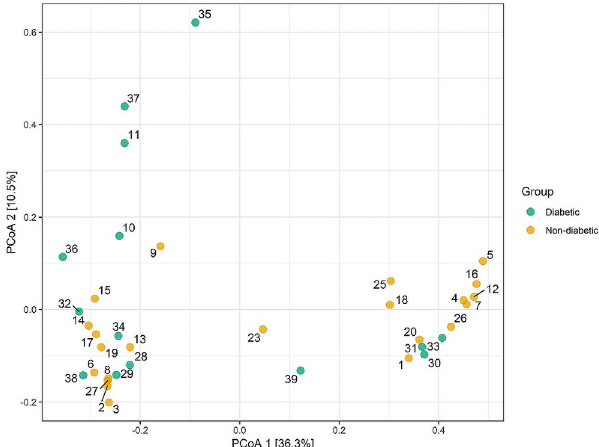
Fig 5. Principal coordinates analysis of microbiome beta diversity by diabetes